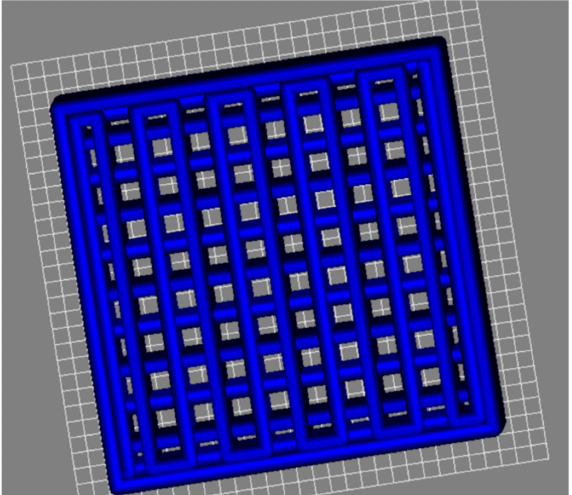
Figure 4. Planned scaffold structure designed according to the CAD model presented in Figure 1 of the article [26] using rods with d = 0.410 mm, a center to center distance between successive filaments,